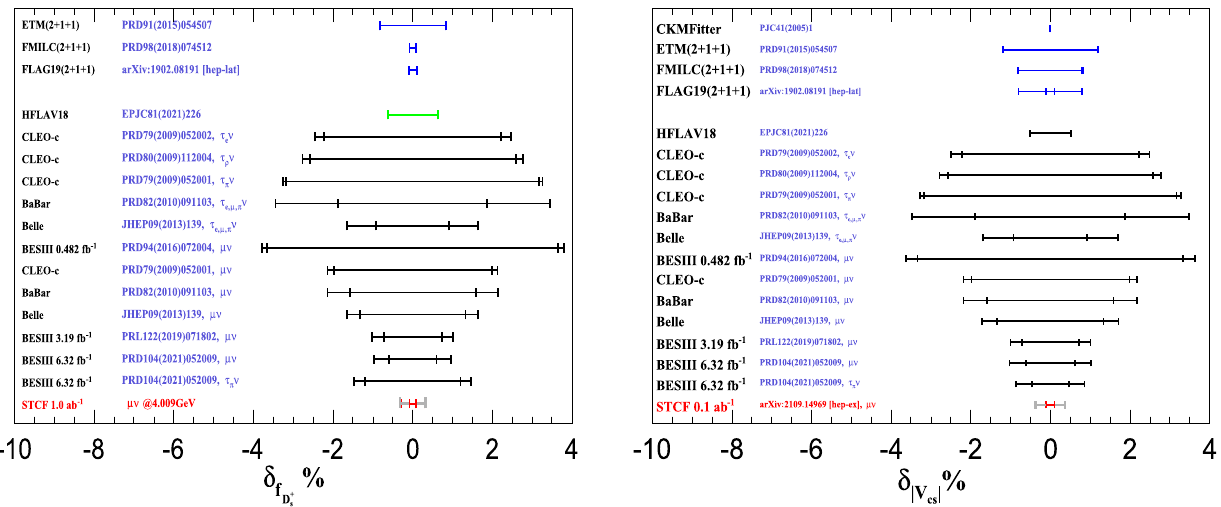
Fig. 7 The comparisons of δ f (left) and δ | V (right) with previous measurements, the red region represents the statistical uncertainty and the cs | D + s grey are those including systematic uncertainty